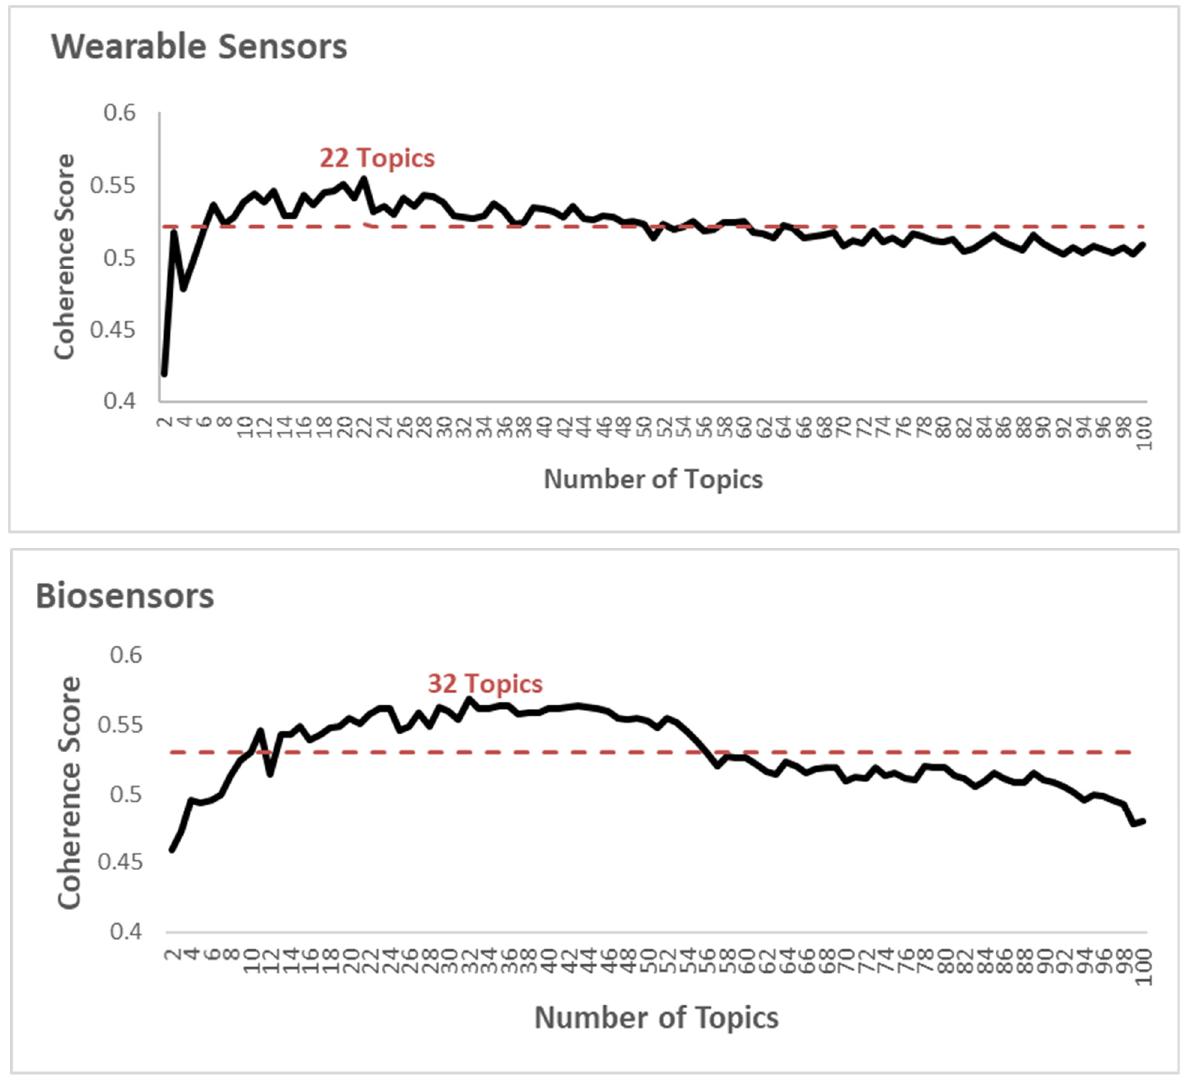
Figure 1. Topic coherence score with a different number of topics in wearable sensor, biosensor and wireless network sensor with the sliding window size of 100.